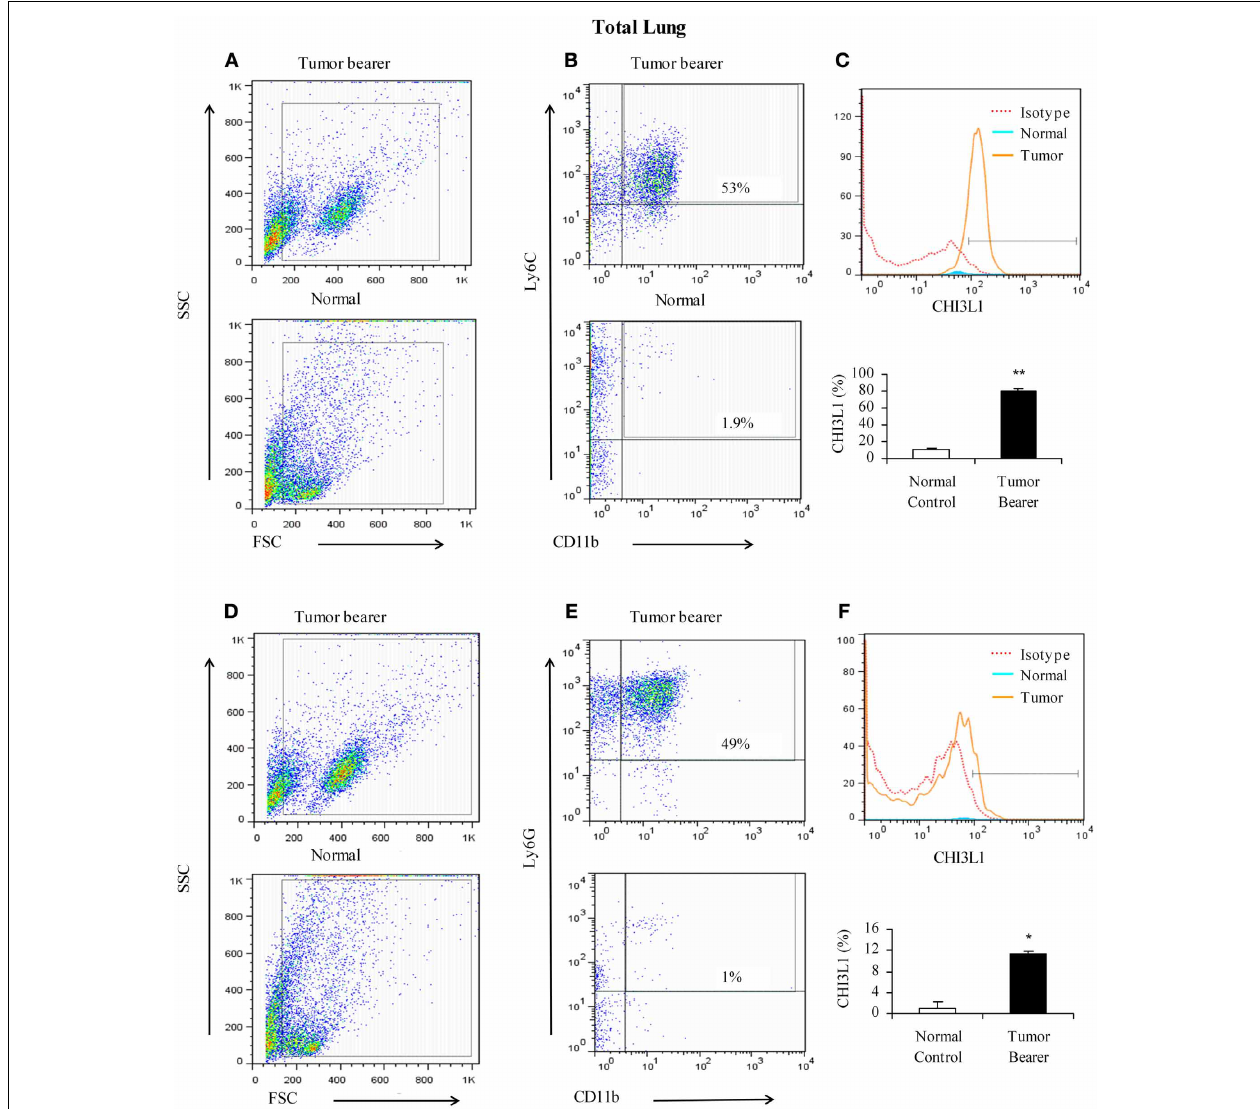
FIGURE 3 | CHI3L1 is expressed at higher levels in CD11b + Ly6C + total lung cells in 2-week mammary tumor bearers. (A,D) Representative scatter plots of forward scatter vs. side scatter in total lung from normal and tumor bearers; (B) CD11b + Ly6C + cells from total lungs of normal and tumor bearers and assessed for CHI3L1 expression; (C) Representative overlay